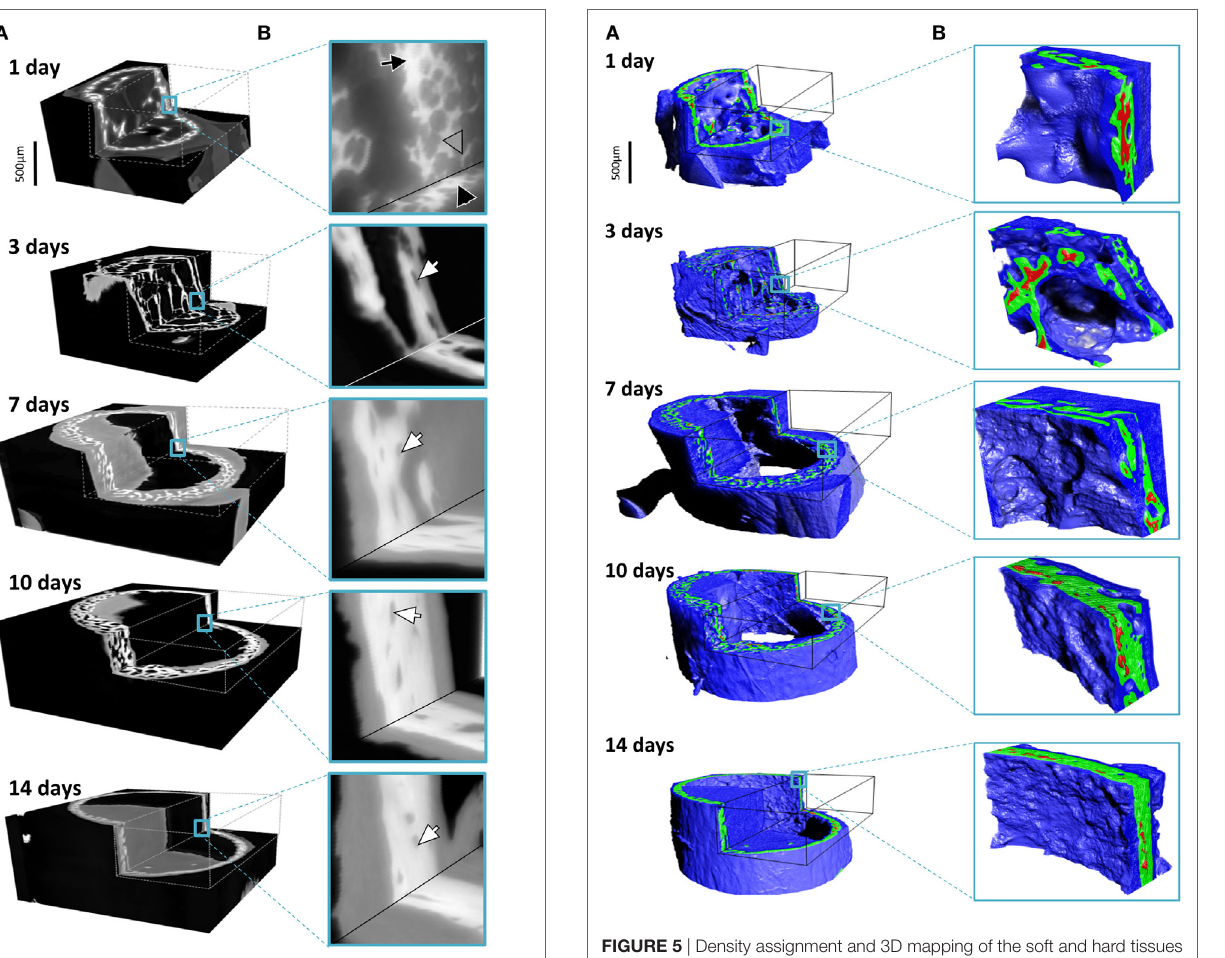
FigUre 4 | (a) Graphic representations of typical 3D datasets with cutouts to reveal the holotomography calculated mass-density distributions including bone and soft tissues in the developing limb structures. Note that the growing bones were scanned in air, here colorized in black, with an approximate mass density of 0, clearly distinguishable in 3D from the soft and hard tissues. (B) Insets hint to the distribution of fine details in the gray values associated with both bone and the formative soft tissues. In the 1 day data, a black arrow pinpoints bone regions with high density and very thin structures are marked by a gray arrowhead. In the older samples, arrowheads highlight osteocyte